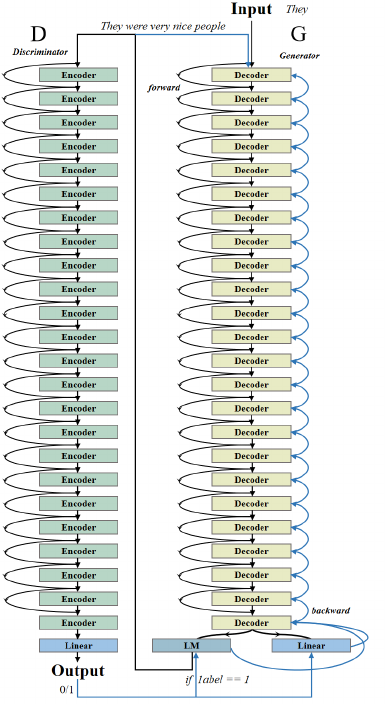
Figure 4. Training process of discriminator (BERT large ) and generator (GPT-2 medium ) in EvoText. The black line indicates the forward propagation process, and the blue line indicates the reverse fine-tuning process after acquiring the label.